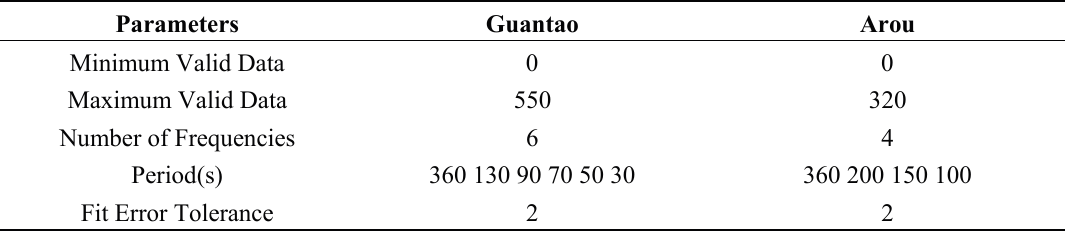
Table 1. HANTS parameters setting for two study sites: Guantao and